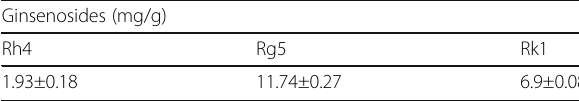
Table 2 Ginsenoside contents in